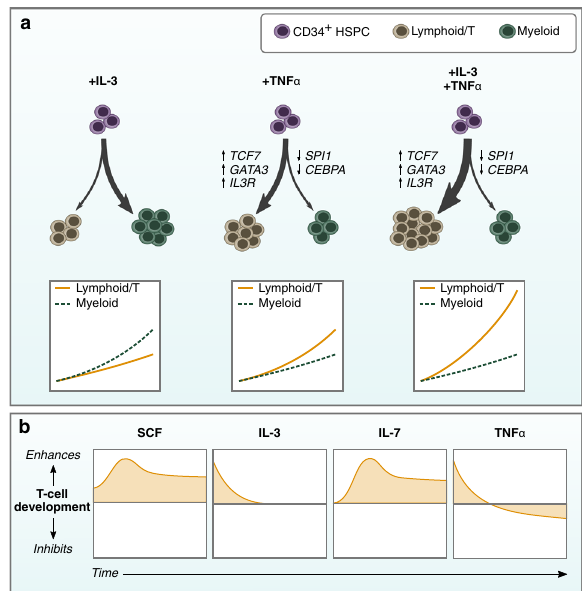
Fig. 7 TNF α couples T-lineage differentiation with IL-3-induced proliferation. a Individually, IL-3 stimulates proliferation of myeloid- biased CD34 + HSPCs while TNF α induces T-lineage differentiation by positively regulating Notch target genes. It also increases the proportion of cells responsive to IL-3 by regulating the IL-3 receptor. When combined, IL-3 provides strong proliferative signals to developing lymphocytes, leading to substantial expansion of T-lineage cells. b The positive effects of IL-3 and TNF α are on T-cell speci fi cation where cells have limited responsiveness to IL-7. Once T-lineage development is initiated, SCF and IL-7 become the drivers of proliferation, and responsiveness to IL-3 and TNF α is lost. TNF α becomes inhibitory when cells enter developmental stages associated with positive and negative